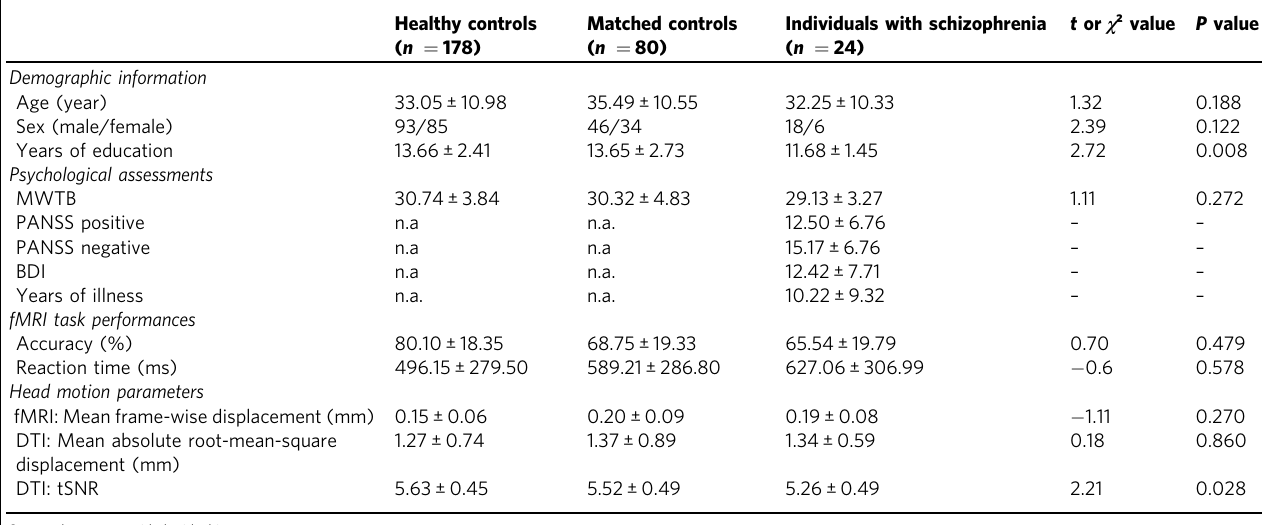
Table 1 Characteristics for the healthy control and schizophrenia samples.